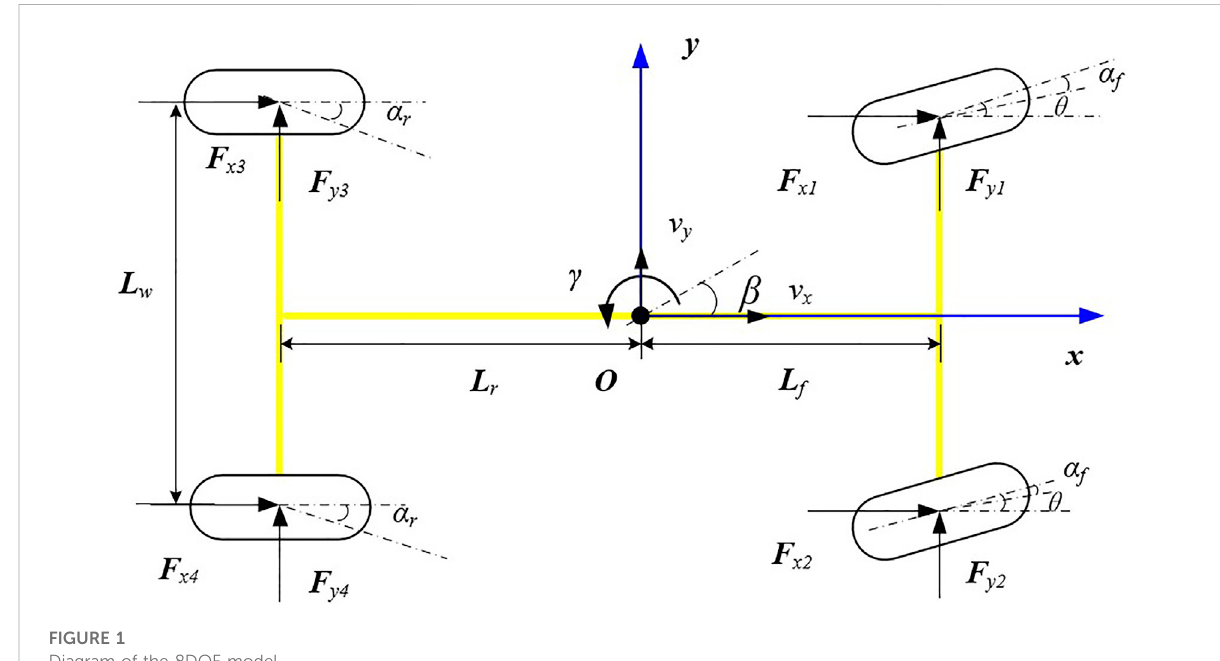
FIGURE 1 Diagram of the 8DOF model.